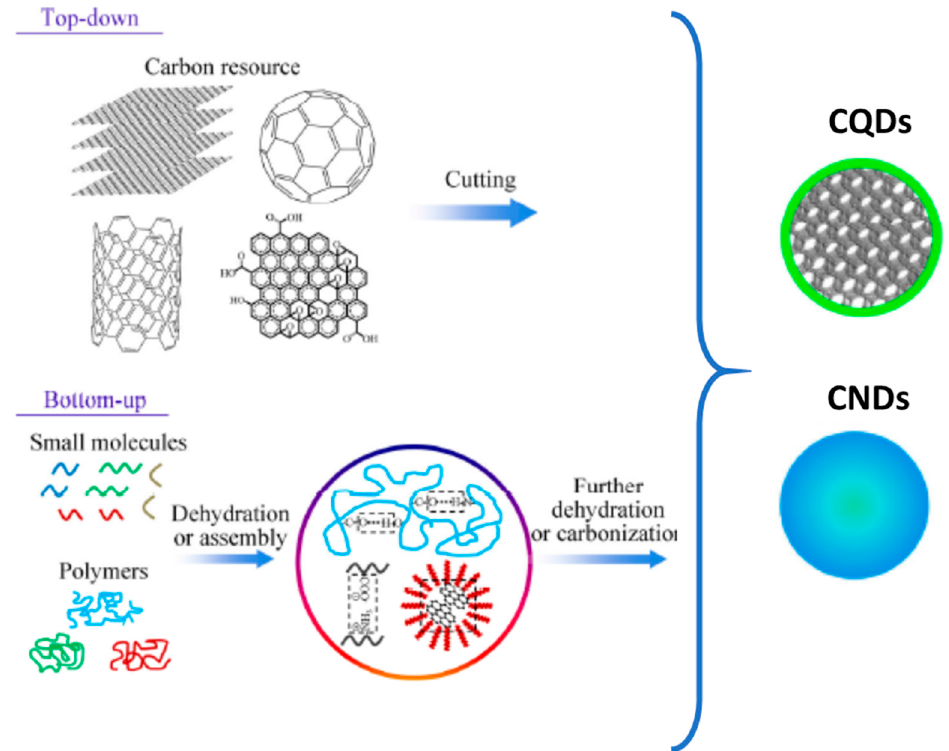
Figure 1. Top-down and bottom-up approaches; CQDs indicates crystalline carbon quantum dots, CNDs disordered carbon nanodots ( vide infra ). Adapted from [31] with permission of Springer,